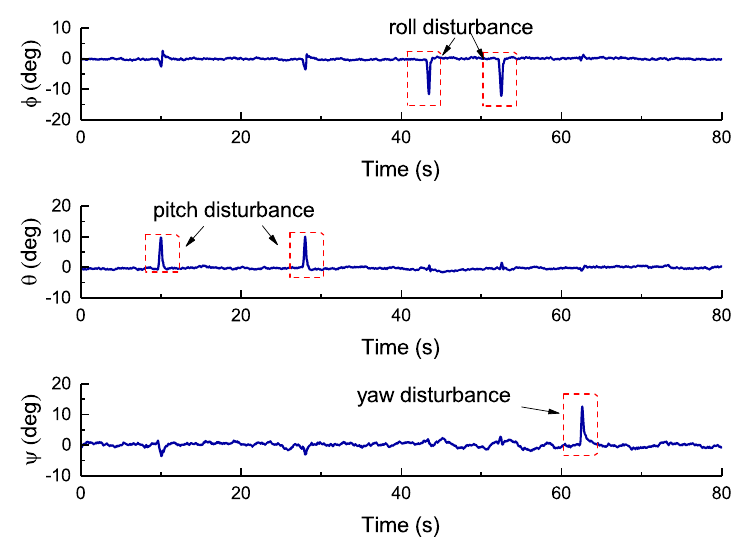
Figure 4. Attitude of NTAUV under I&I control with disturbance on each axis.